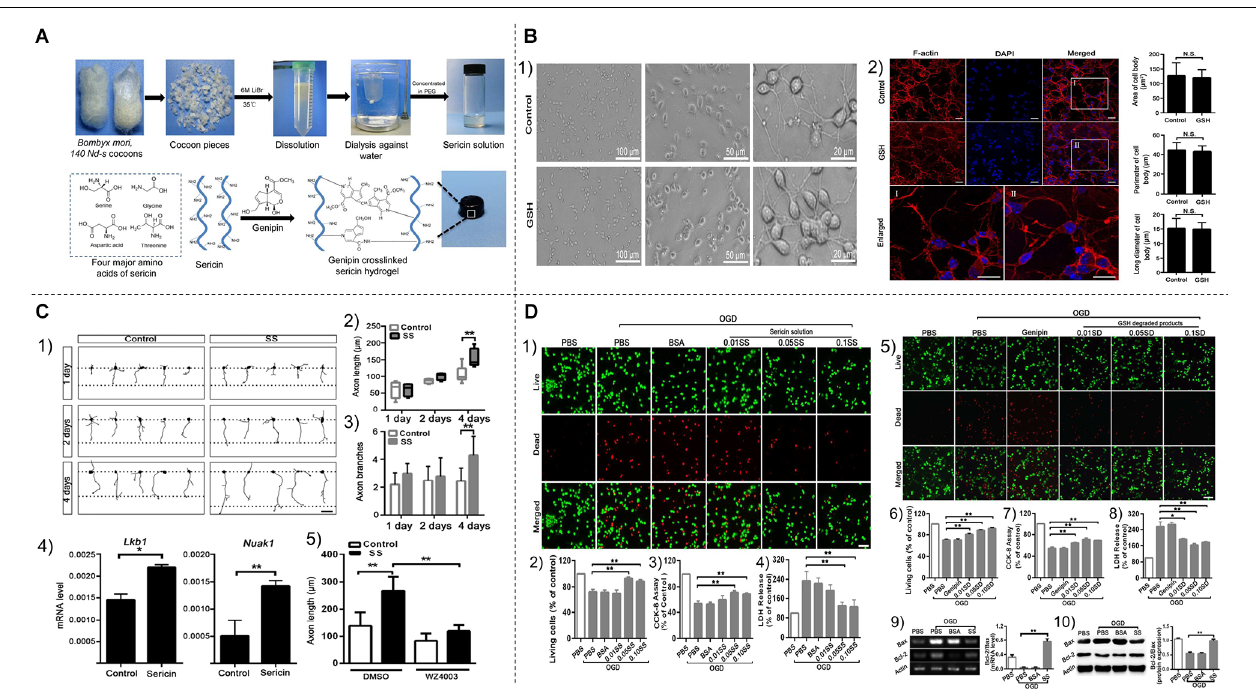
FIGURE 8 | (A) Schematic diagram of the preparation of silk-based ginsenoside cross-linked silk glue hydrogel (GSH). (B) Effective adhesion, growth, and spreading of primary neurons on the GSH surface. (C) Filament gum promotes axonal growth and branching in vitro . (1 ) Axons extending from neurons were observed after 1, 2, and 4 days of treatment with or without filamentous glue solution (SS). Scale bar, 40 µ m. (2 and 3; 1) Quantification of neuronal axon length and axon branching ( n = 20–25). (4; 1) mRNA levels of Lkb1 and NUAK1 genes in primary neurons after 48 h of treatment shown in (1) . (5) Axon lengths of DMSO or WZ4003 (an Lkb1-NUAK1 pathway inhibitor) treated primary neurons in the presence (control) or absence of filamentous glue (SS). (D) Neuroprotective effects of filamentous gum solution and glutathione degradation products on primary cortical neurons against oxygen-glucose deprivation (OGD) injury. (1) Neurons were treated with PBS, BSA, and silk gum solution (SS) for 1 h, followed by routine incubation for 24 h. Neurons treated with PBS but not OGD were the non-OGD control group. All cells were stained for live and dead cells. (2–4) Quantification of the percentage of live cells (normalized to non-OGD control; 2 ), CCK-8 assay of od values at 450 nm (3) , and LDH release from neurons that received the indicated treatments in (1; 4) . Scale bar, 50 µ m. Each experiment was performed three times, per treatment; three experiments were repeated. (5) Neurons were treated with specific concentrations of PBS, BSA, and GSH degradation products (SD) for 1 h, followed by routine incubation for 24 h. Neurons treated with PBS but not OGD were non-OGD controls. All cells were stained for live and dead cells. (6–8) Percentage of live cells (normalized to non-OGD control; 6 ), OD at 450 nm determined by CCK-8 (7) , and LDH release from neurons receiving the indicated treatments in (5; 8) . (9) The relative mRNA levels of Bcl-2 and Bax were detected by real-time fluorescent quantitative PCR (Real time PCR, left), and the band intensity ratio of Bcl-2 and Bax was quantified (right). (10) Protein expression of Bcl-2 and Bax in each treatment group was analyzed by Western blotting (left), and the band intensity ratios of Bcl-2 and Bax were quantified (right) accordingly. * P < 0.05; ** P < 0.01; Student’s t -test. Reprinted (adapted) with permission from Wang Z. et al. (2015). Copyright 2015 American Chemical